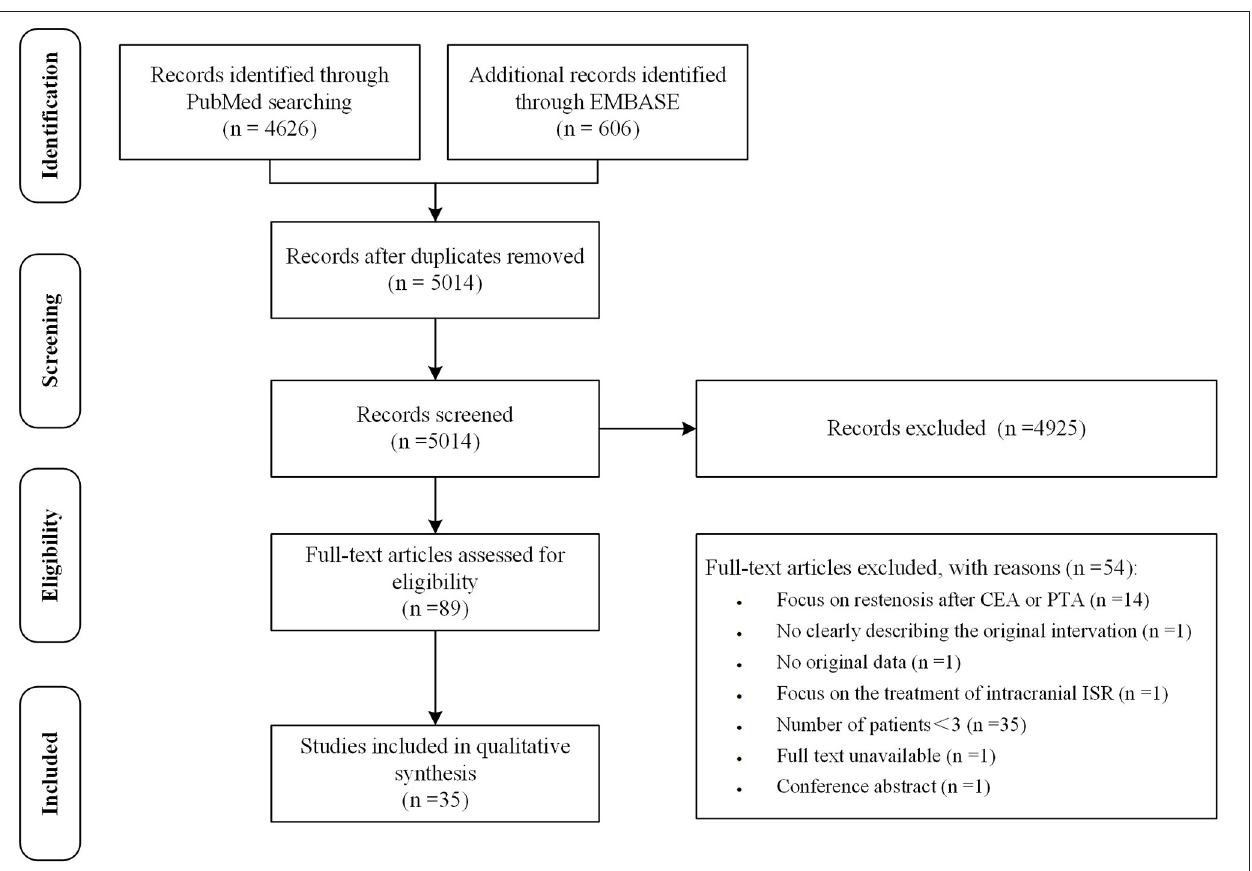
FIGURE 1 | The preferred reporting items for systematic reviews and meta-analyses flowchart of the study selection.